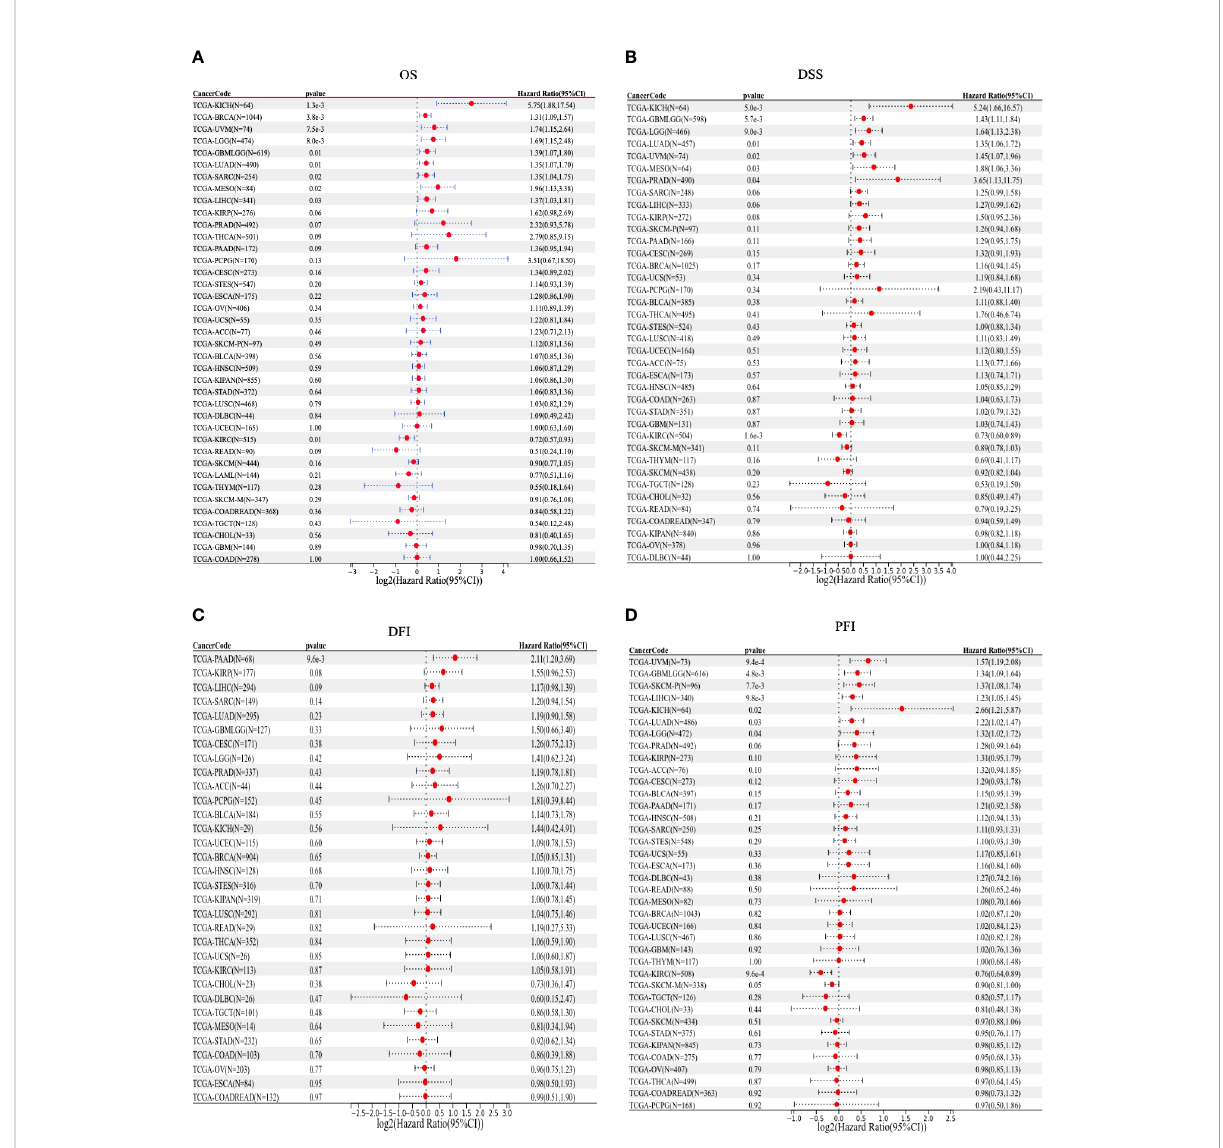
FIGURE 5 Forest plots showing results of univariate Cox regression analysis for (A) OS, (B) DSS, (C) DFI, and (D)